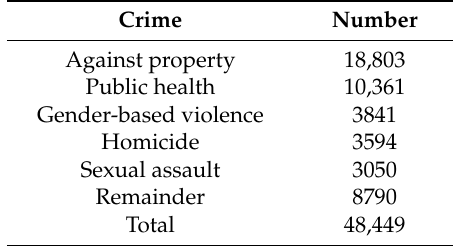
Table 2. Types of offences for which men receive custodial sentences.